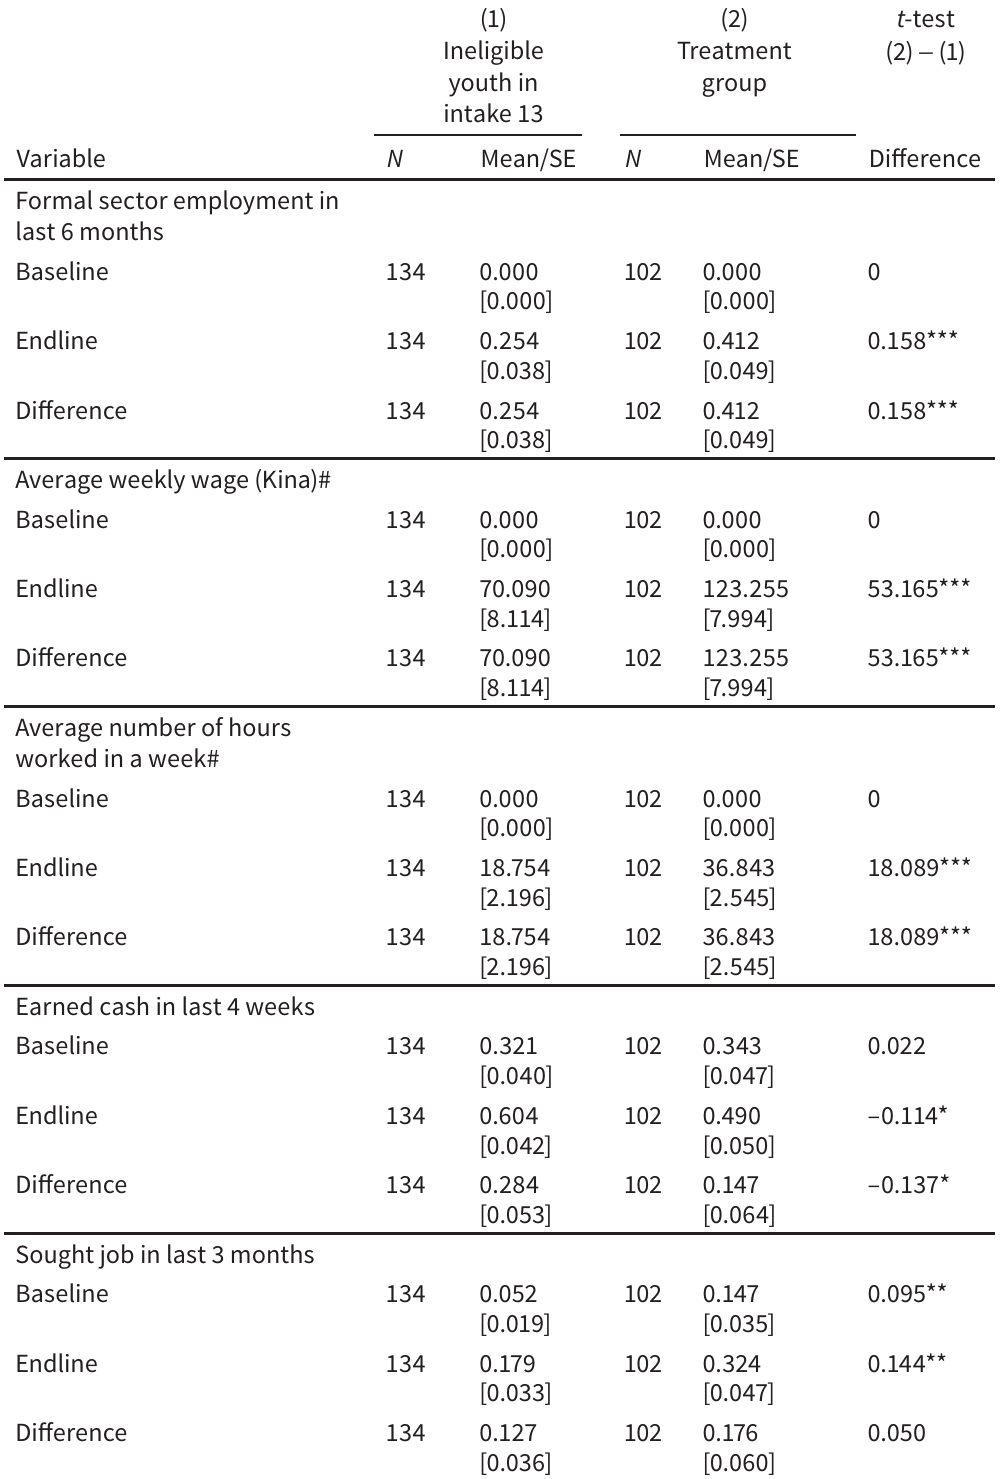
Table A7 Differences in outcomes between youth in the treatment group and youth who were ineligible in intake